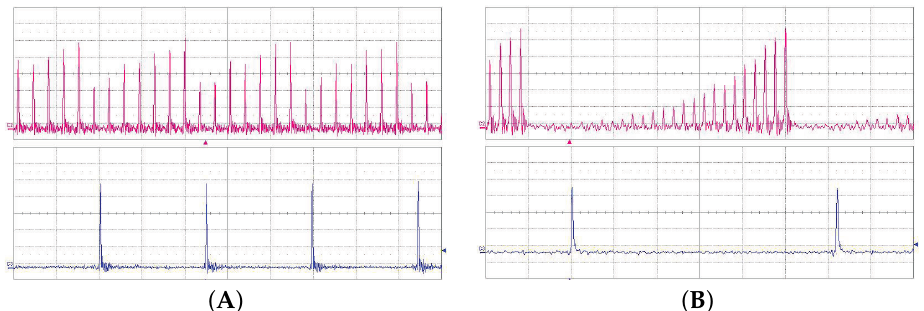
Figure 14. Oscillogram of the signal ring cavity OPO radiation at 1.53 µ m (upper trace) and 1.06 µ m pump (lower trace). ( A ) Pulse multiplication factor n = 7, time scale 5ns/div. ( B ) Pulse multiplication factor n = 27, time scale